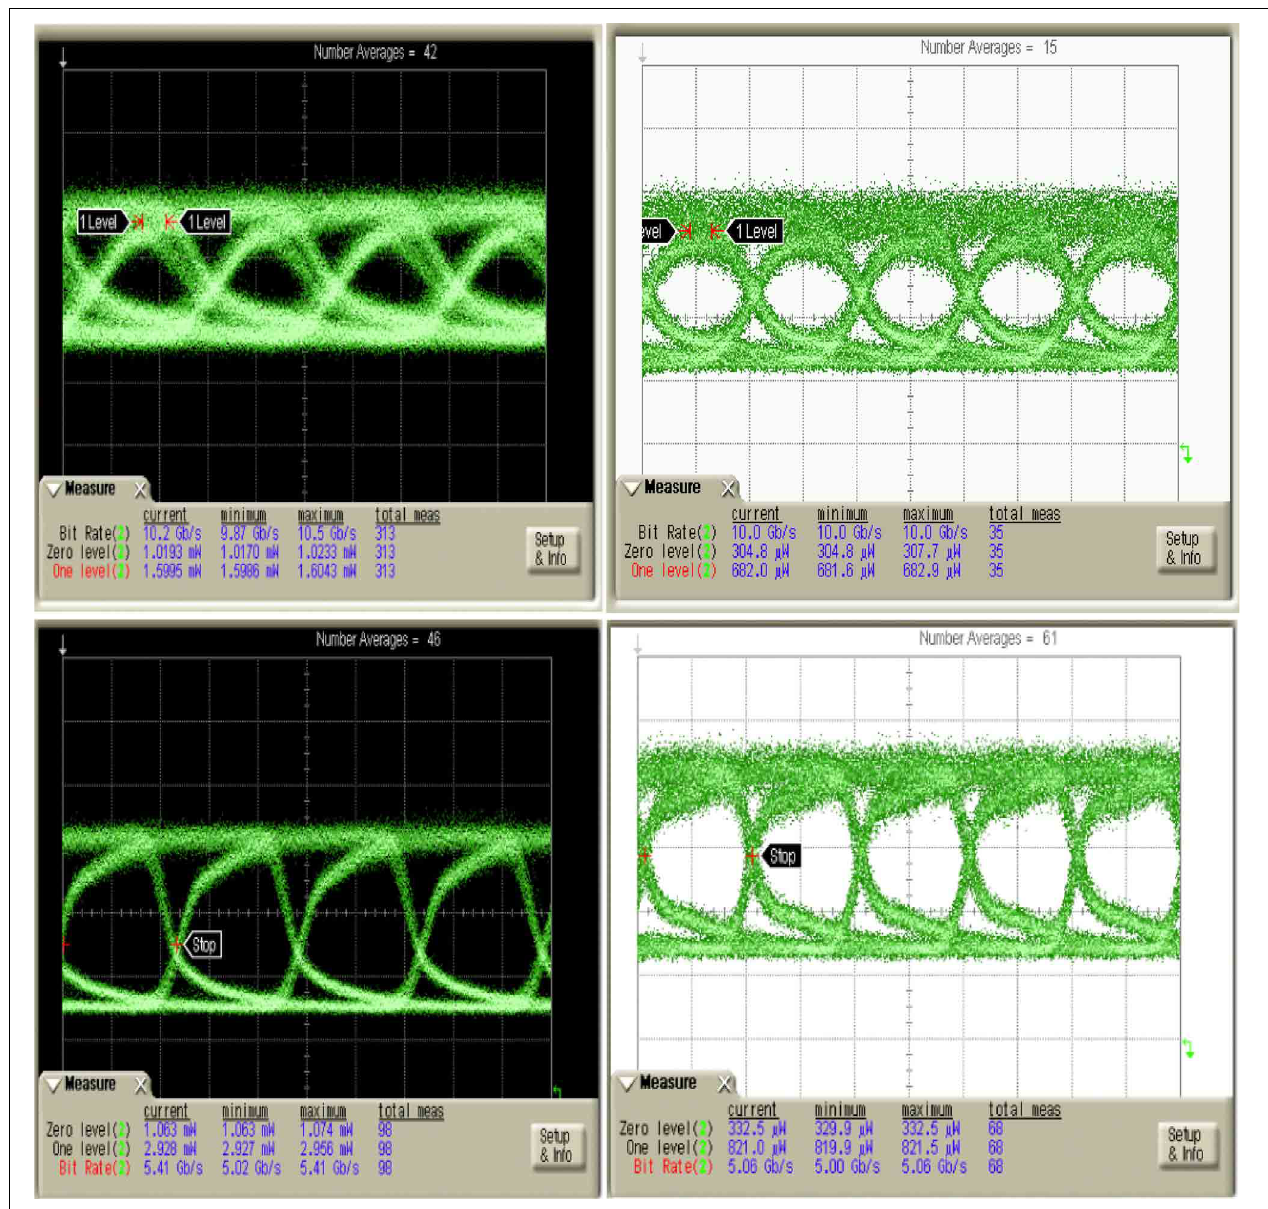
the input of the driver) are shown on the left for a chip with driver variant one and a 1mm long modulator and on the right for a chip with driver variant two combined with a 2mm long